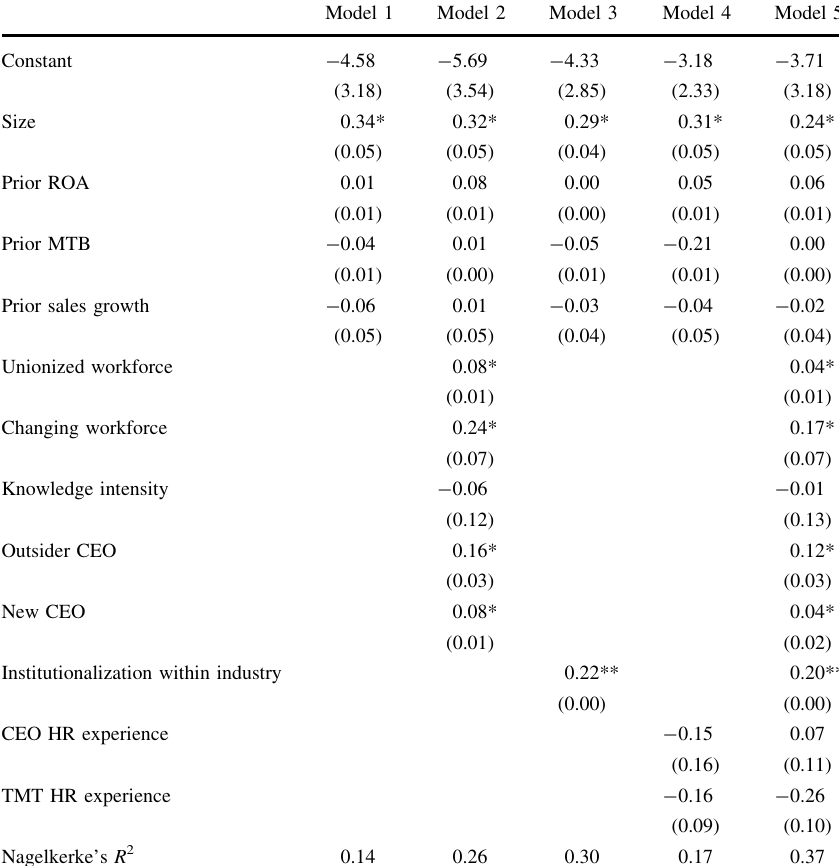
Table 3 Results of logistic regression with CHRO-proneness as dependent